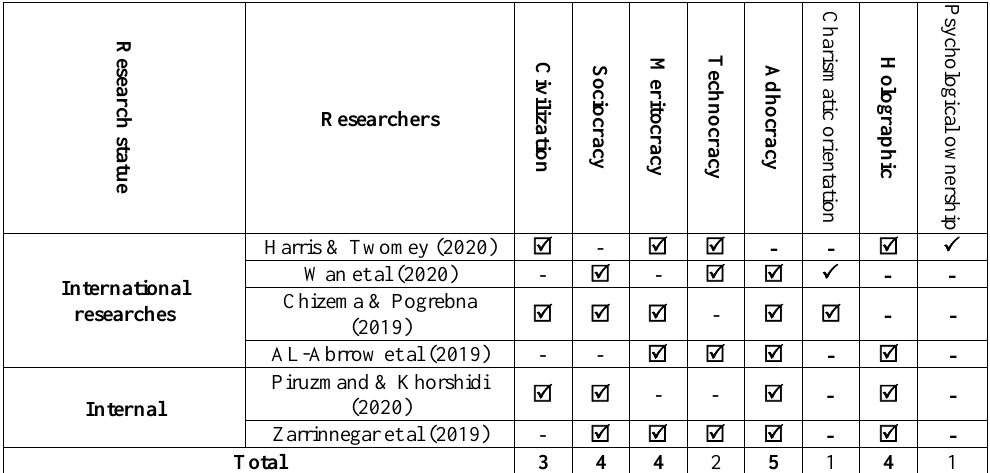
Table 6. the process of determining research